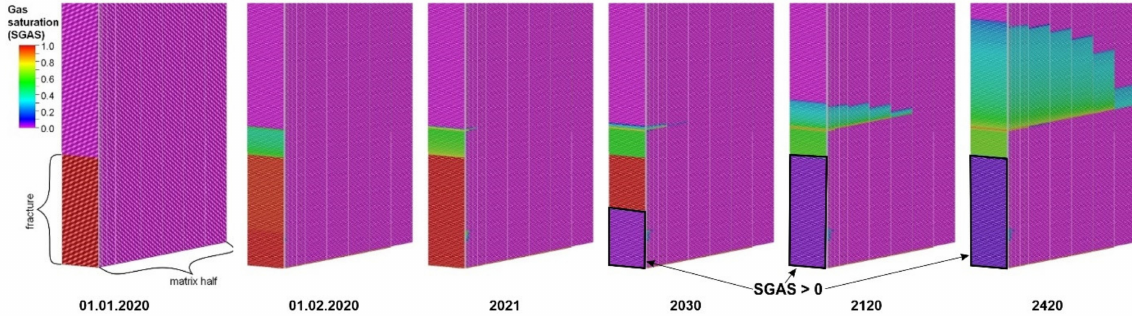
Figure 27. CO 2 migration in the fracture and pores of the overburden rocks. Distribution of CO 2 saturation as a function of time. Model II, Sub-scenario 3.